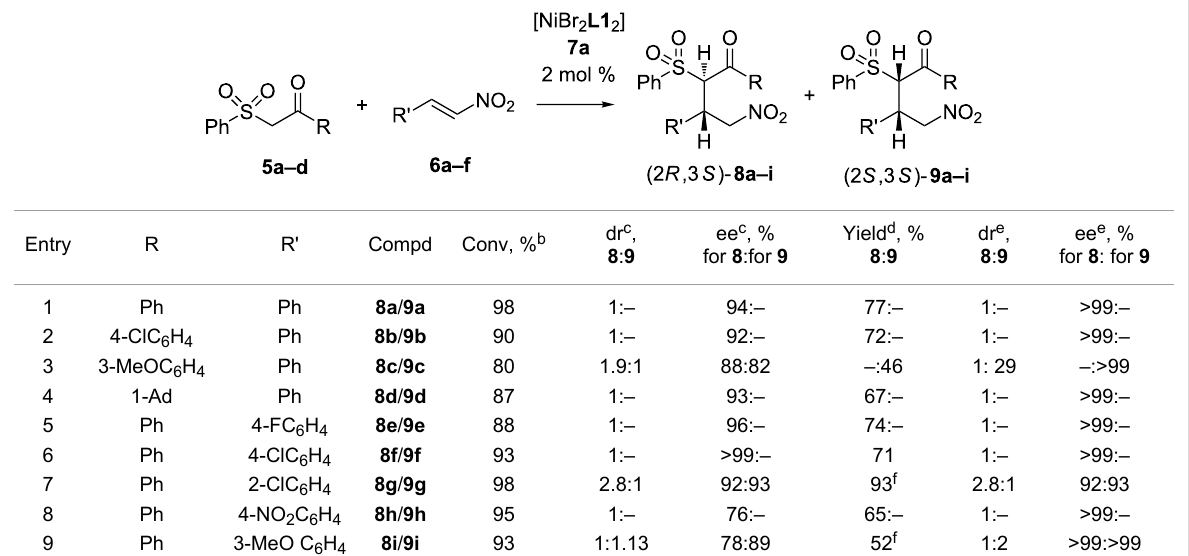
phy (for entry 7); f isolated yields for a mixtures of diastereomers.